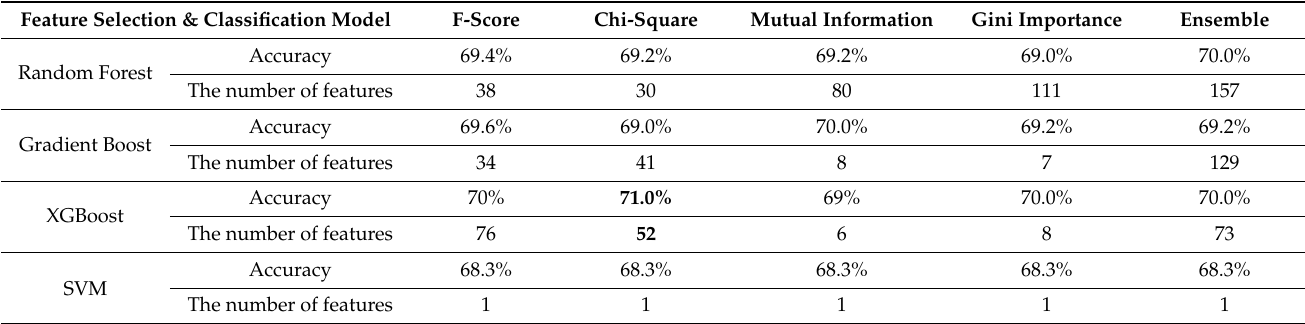
Table 3. The result of calculating the number of features showing the highest classification performance when classified while adding features one by